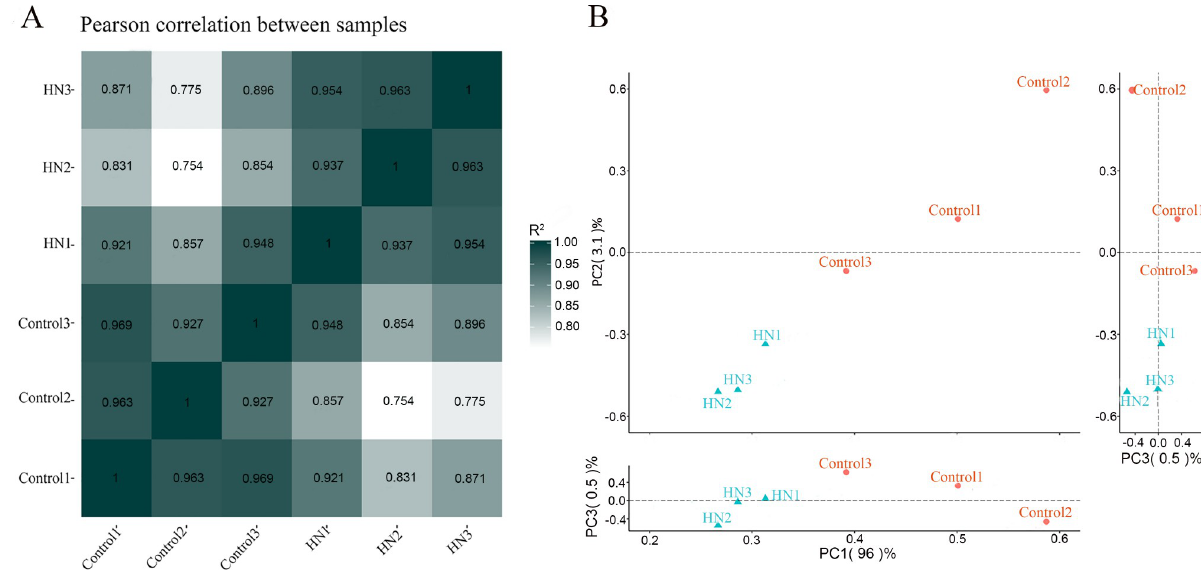
Fig 2. The Pearson correlation coefficient between samples and principal component analysis. (A) Pearson correlation coefficient (PCC) between samples; the closer the square value of R is to 1, the higher the correlation between samples. (B) Principal Components Analysis